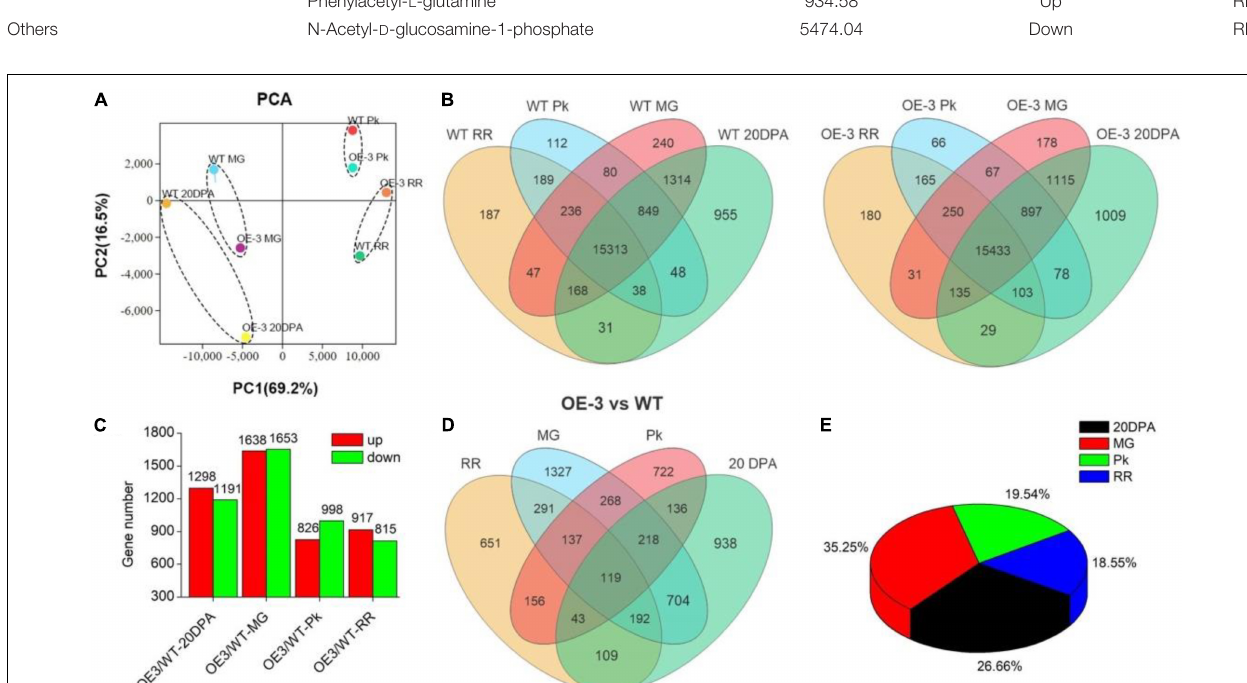
FIGURE 8 | Identification of differentially expressed genes (DEGs) in Ailsa Craig tomato in OE-3. (A) Principal component analysis (PCA) of DEGs. PCA score plots (PC1 vs. PC2) for the first two principal components under SlAAE3-1 overexpression. Each sample was marked using individual color. (B) Venn diagrams showing overlap of all detected genes in WT and OE-3, respectively. (C) Statistics of DEGs in OE-3 compared with WT at different development stages. Overlap (D) and percentage occupied (E) by DEGs over development stages.